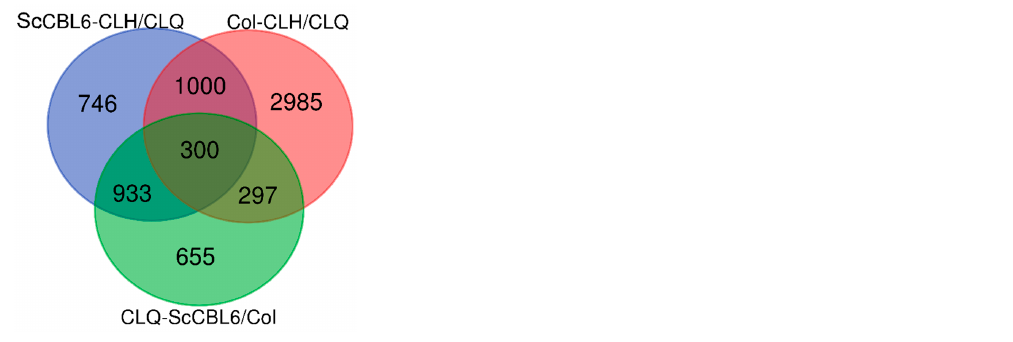
Figure 4. Venn diagram of overlapping and specific differentially expressed genes (DEGs) under different conditions. CLQ, before cold treatment; CLH, after cold treatment; ScCBL6, ScCBL6-overexpressing Arabidopsis ; Col, wild-type Arabidopsis .